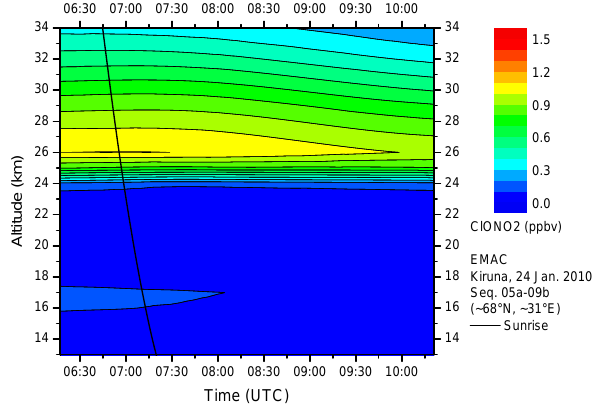
Fig. 9. ClONO 2 mixing ratios on 24 January 2010 as simulated by the CCM EMAC.